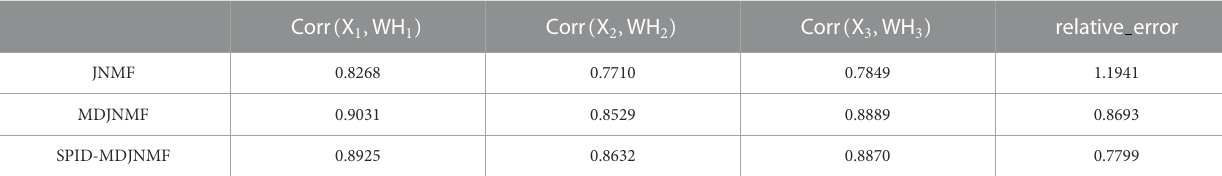
TABLE 1 Comparison of relative errors and correlation coef fi cients of